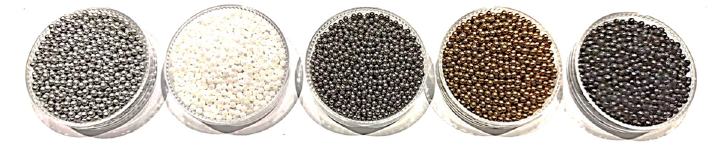
Figure 7. Particle samples of different materials.